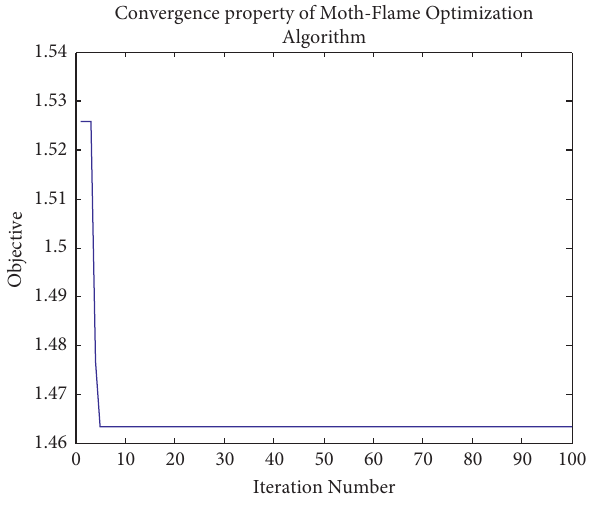
Figure 6: Convergence property of MFO.